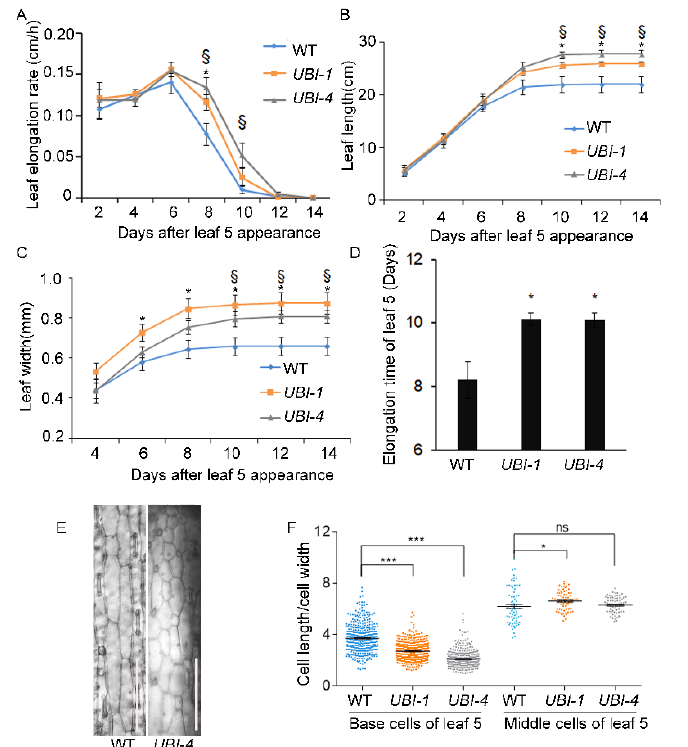
Figure 2. TaKLU regulated the time of leaf elongation and cell division. ( A – C ) Dynamic analysis of the elongation rate ( A ), length ( B ) and width ( C ) of leaf 5 from 2 to 14 days after its appearance in WT and UBI::TaKLU plants ( n > 7). ( D ) Elongation time of leaf 5 ( n > 7). Leaf elongation time represents the minimum time required for leaf growth to enter the plateau stage (no significant change in leaf length). ( E ) Characteristics of base cells of leaf 5 were shown at 16 days after its appearance in WT (left) and UBI::TaKLU (right, UBI-4 ) plants. ( F ) The aspect ratio of the leaf base cells in panel ( E ) ( n > 68). Bars indicate SE. Size bars represent 200 μm ( E ). * indicates significant differences between UBI-1 and WT plants at p < 0.05 ( t -test), § indicates significant differences between UBI-4 and WT plants at p < 0.05 ( t -test) in panel ( A – C ). Asterisks (*) and (***) indicate significant differences from their WT at p < 0.05 and p < 0.001 ( t -test) in panel ( D ) and ( F ), respectively. “ns” means no significant difference.